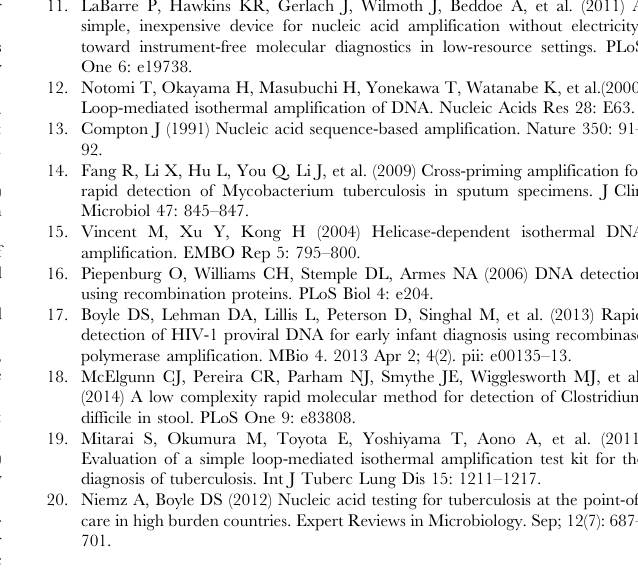
Table S1 Thermal profiles from preliminary screening of SAT concentrations of 50%–80% (w/v) after